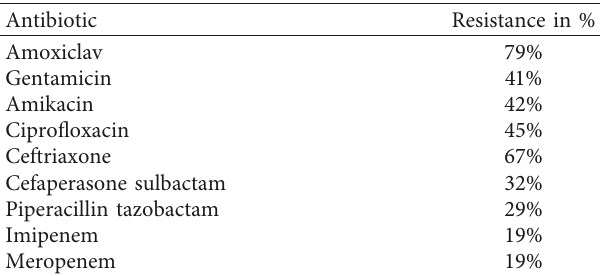
Table 3: Incidence of ESBL production in classical Klebsiella pneumoniae (C-Kp) and hypervirulent Klebsiella pneumoniae (Hv- Kp) isolates from various types of